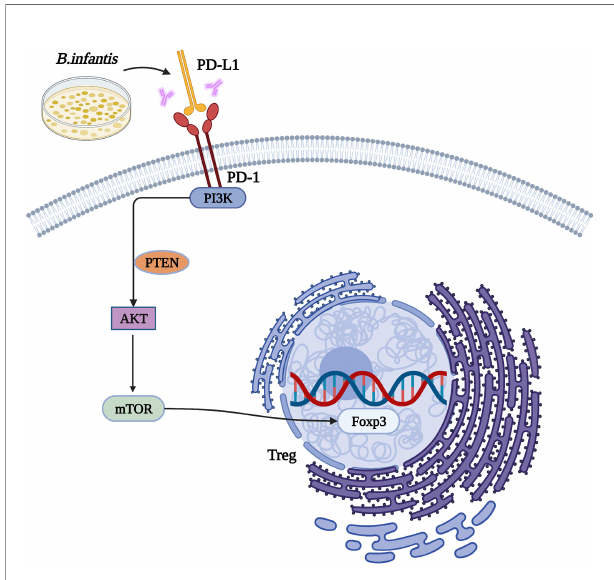
FIGURE 6 | The mechanism by which Bi fi dobacterium infantis mediates the PD-1/PD-L1 pathway by inhibiting Foxp3